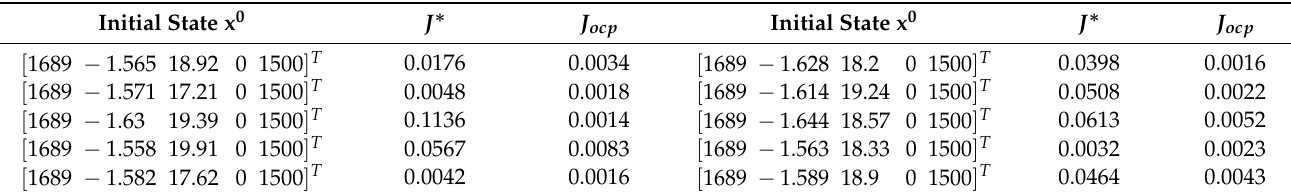
Table 2. Results of the computational experiment for random initial